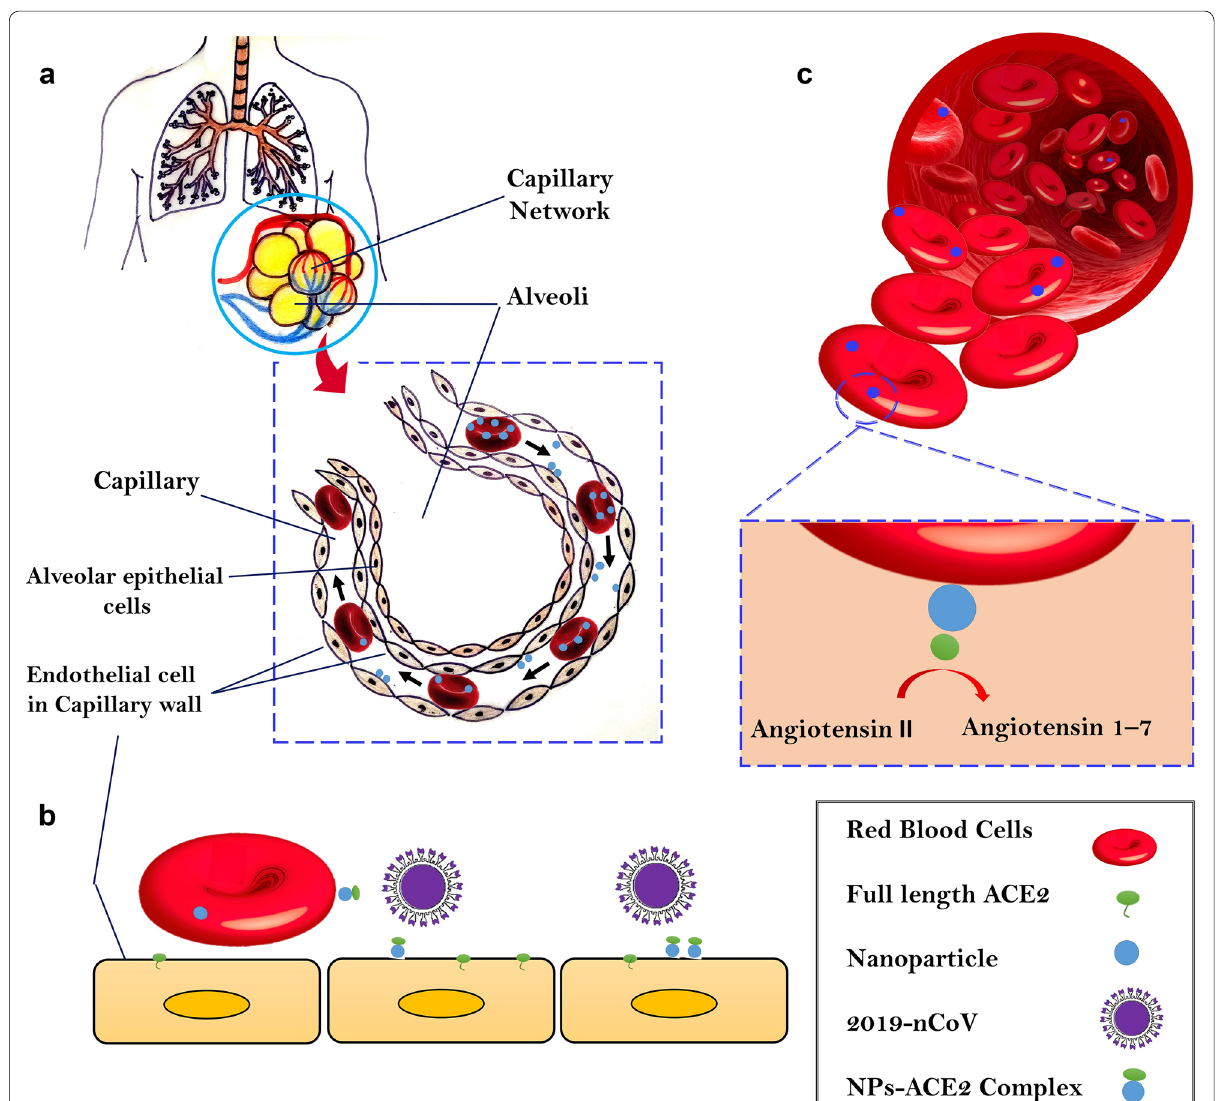
Fig. 1 a Schematic of the therapeutic triple complex in blood circulation. b RBC–NPs complexes detach from RBCs in small capillaries, this process increases the rACE2 in lung capillaries and saving cellular rACE2 activity. c Also, it acts as a decoy for 2019‑nCoV and decrease viral spreading.